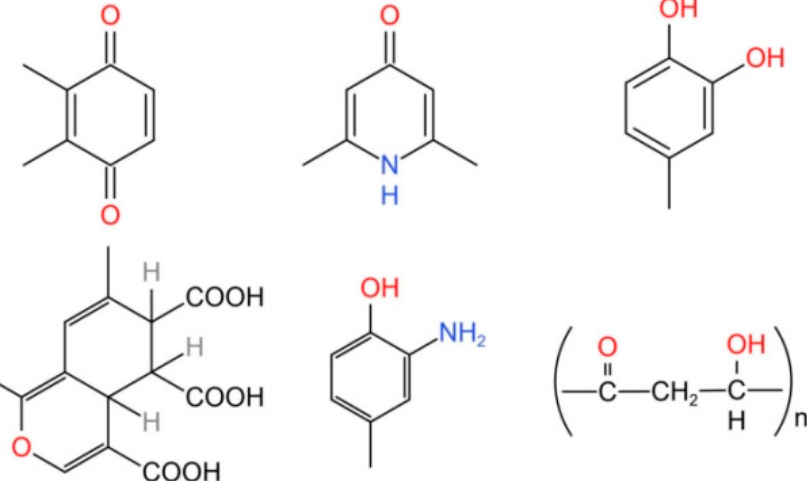
Figure 3. The main functional groups involved in the complexation of the HA binder.